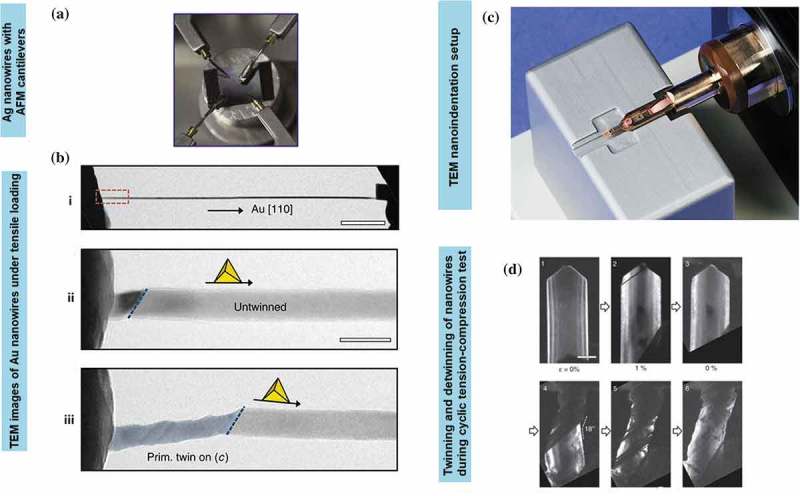
(a) Experimental setup of AFM cantilevers on the SEM stage [225]. The cantilever is mounted on a metal block of screw nut using a stable glue, providing excellent electrical contact with the close-up on the fracture area of the wire. (b) TEM images are used to monitor quantitative tensile tests before, right before and after breaking 20 nm diameter Au nanowires [4]. (c) TEM nanoindentation holder with the sample mounted on the metal rod. The image is originally courtesy of the Model 2030 Ultra-Narrow Gap Tomography Holder from Eden Instruments (http://www.eden-instruments.com). (d) Reversible compressive deformation through twinning and de-twinning transition during cyclic tension-compression. The first tensile loading near the tensile grip (image 1 to 2) and eliminated entirely by de-twinning during compression (images 2 and 3). The successive nucleation and extension of parallel nanotwins along the same slip area (images 4 and 5) with the accommodation of de-twinning during subsequent compression (image 6) [4]. (Reproduced from [225] with permission from IOP Publishing and reproduced from [4] with permission from Nature Publishing Group).